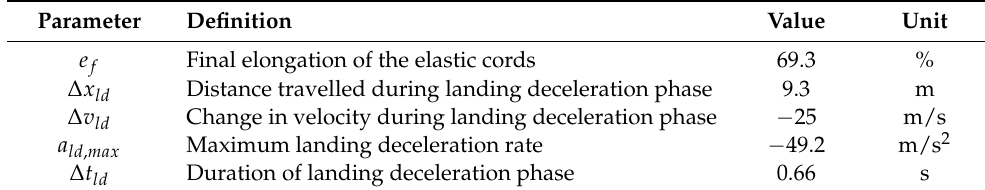
Table 9. The dynamics of the carriage during the landing deceleration